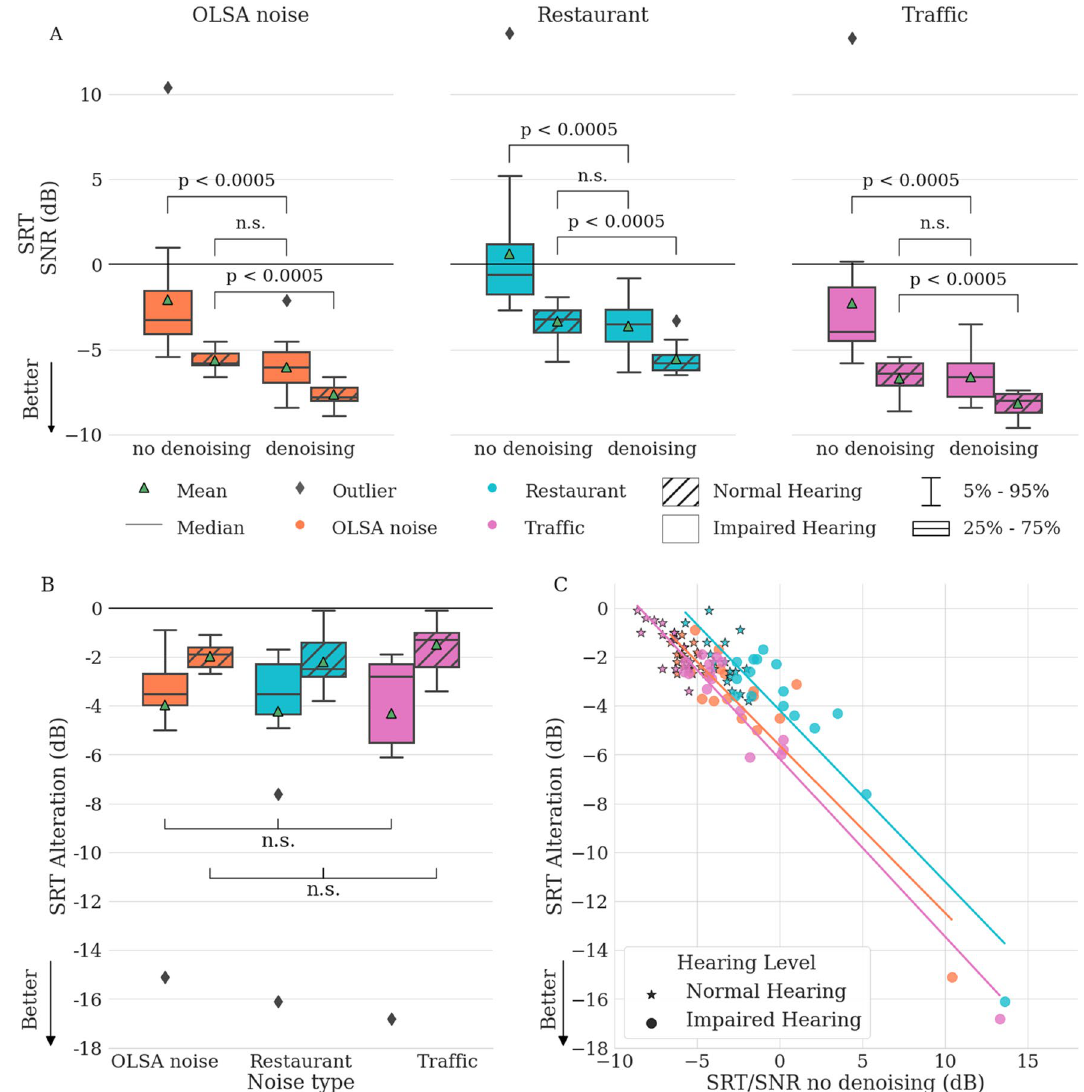
Figure 3. Reducing speech reception thresholds (SRT) on the OLSA test using our denoising system for hearing impaired (n = 16) and normal hearing (n = 17) subjects. ( A ) SRTs for different noise types. Significance levels are shown for Wilcoxon signed-rank test for matched pairs and Mann–Whitney U test for independent samples. ( B ) SRT improvements for each of the six testing conditions (Friedman test). ( C ) SRT improvement vs SRT without denoising. Linear regression fits for each of the three noise type measurements, across all subjects (slopes m = − 0.69, m = − 0.70, m = −